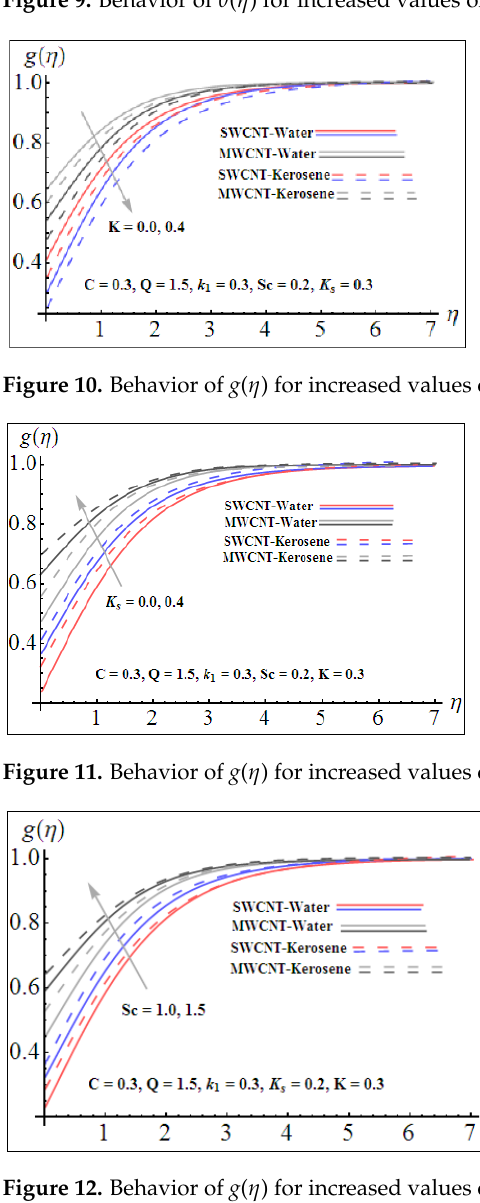
Figure 12. Behavior of g ( η ) for increased values of S c . Table 1. Thermophysical features of base fluid and nanoparticles (SWCNT and MWCNT) [41].